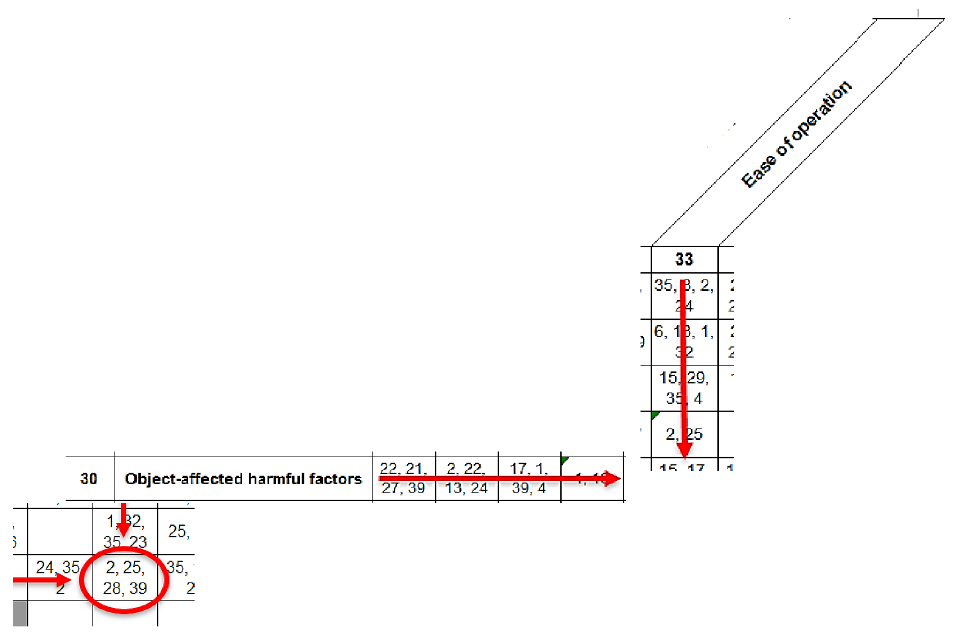
Figure 3. Solving principles resulting from the Altshuller Matrix. *The horizontal arrow indicates which technical parameter improves, while the vertical arrow indicates which technical parameter worsens. The cell intersected by the previous arrows indicates the possible technical solutions and these are highlighted by a circle.